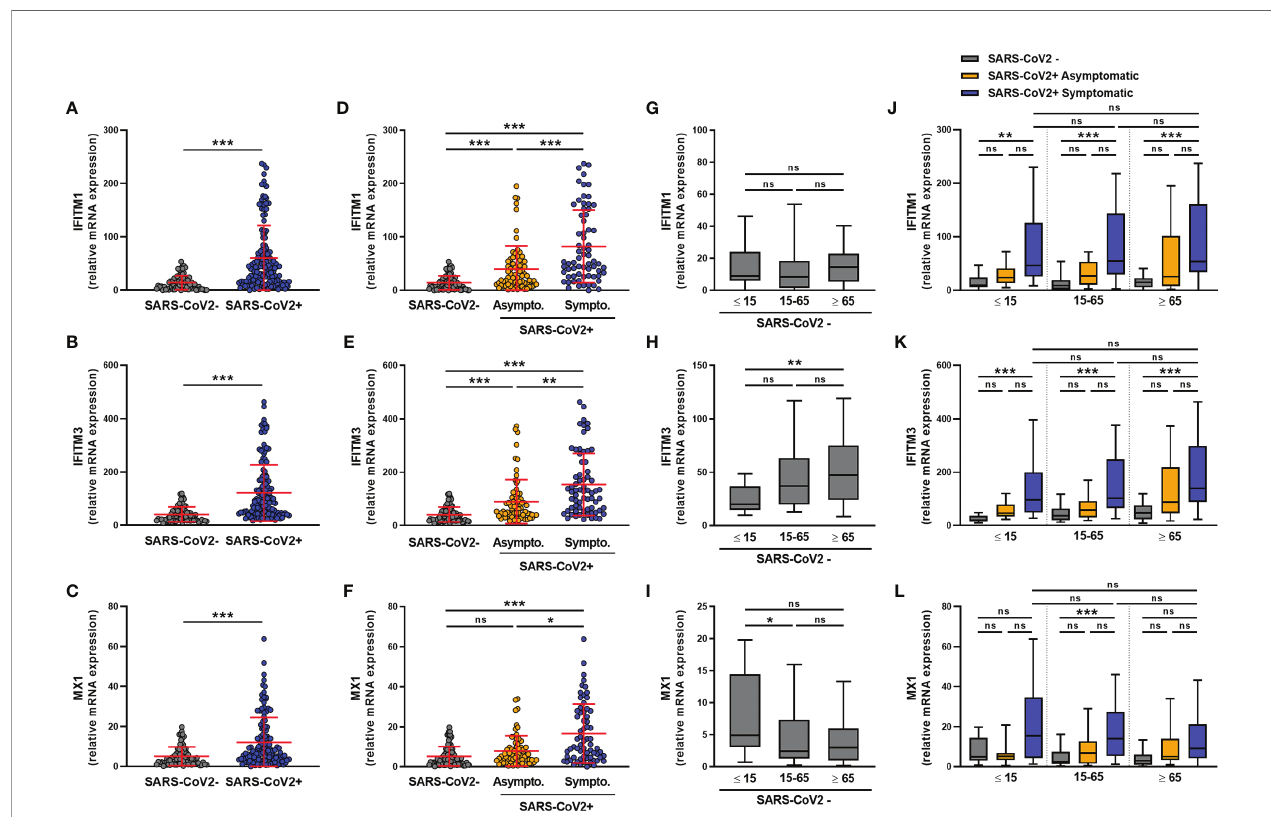
FIGURE 3 | ISG transcript levels are increased in SARS-CoV-2-positive patients. The expression of IFITM1 , IFITM3 and MX1 mRNA was determined by RT-qPCR in nasopharyngeal samples from SARS-CoV-2-infected (n=147) or non-infected (n=79) individuals. A global comparison was performed between data from the two groups (A – C) , a comparison was performed between symptomatic (n=72) and asymptomatic (n=75) SARS-CoV-2-infected individuals (D – F) , and a comparison was analyzed according to the age of individuals: <=15 years old, 15-65 years old and ≥ 65 years old) (G – L) . Each symbol represents a single individual. Boxplots represent the median and 25th to 75th percentiles and whiskers denote the maximum and minimum values. Data are compared using Mann-Whitney (A – C) or Kruskal-Wallis test followed by Dunn ’ s multiple comparison test (D – L) . *p < 0.05, **p < 0.005, ***p < 0.001. ns, not signi fi